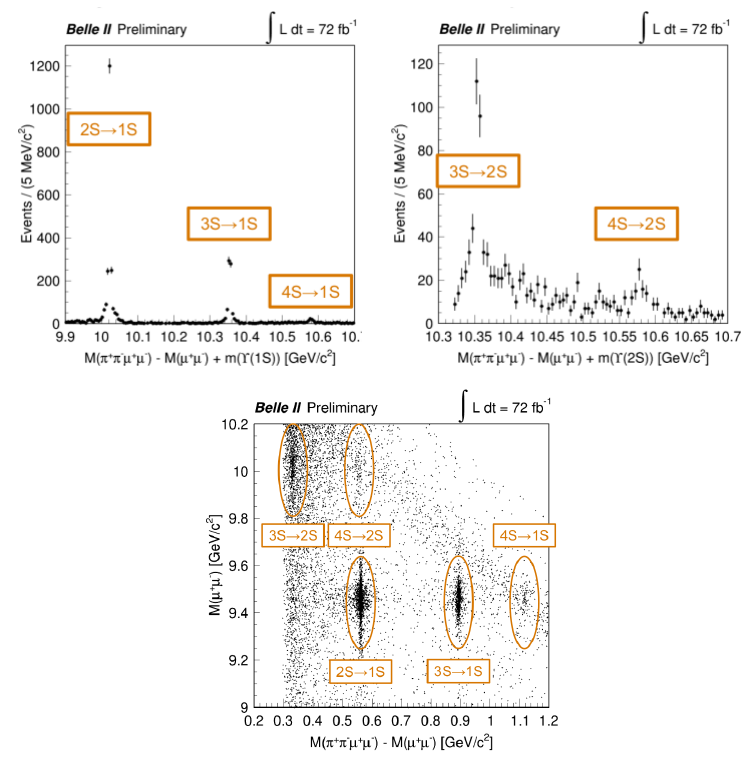
Figure 4: Results for the ISR bottomonium search using 72 fb − 1 of